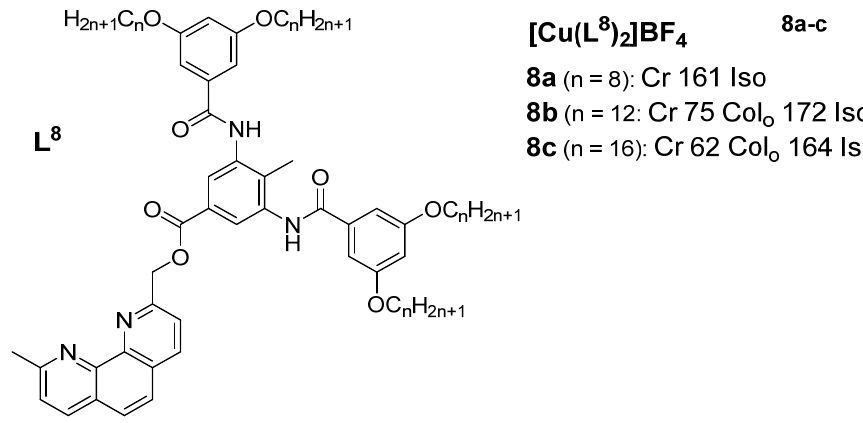
Figure 5. Copper(I) complexes with phenanthroline-based ligands. Temperatures are in (°C) [46].